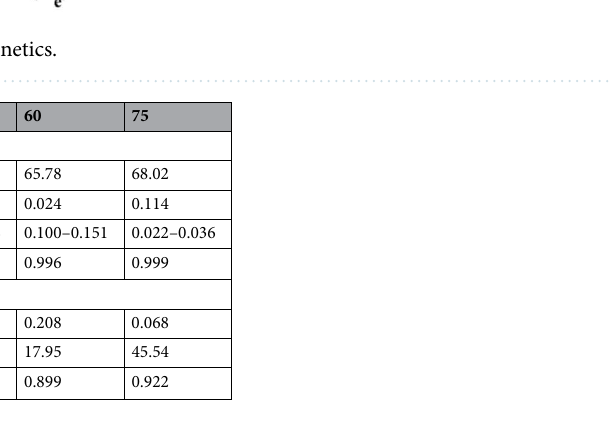
Table 3. Investigation of adsorption isotherm